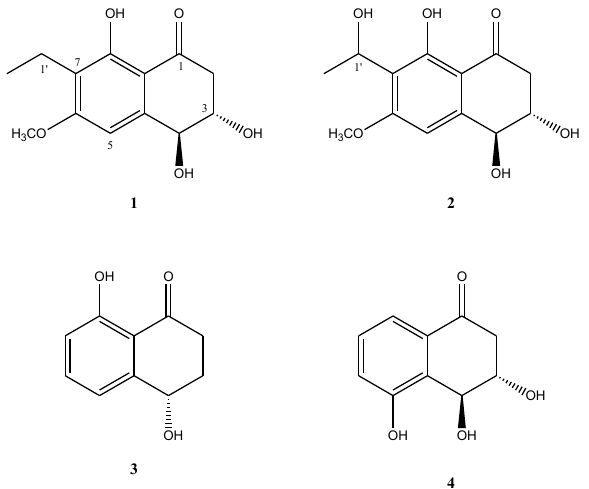
Figure 3. Structures of botryosphaerones D and A, isoscle- rone, and (3 S *,4 S *)-3,4,5-trihydroxytetralone ( 1 - 4 ). The relative configuration was reported for 2 and 4 .